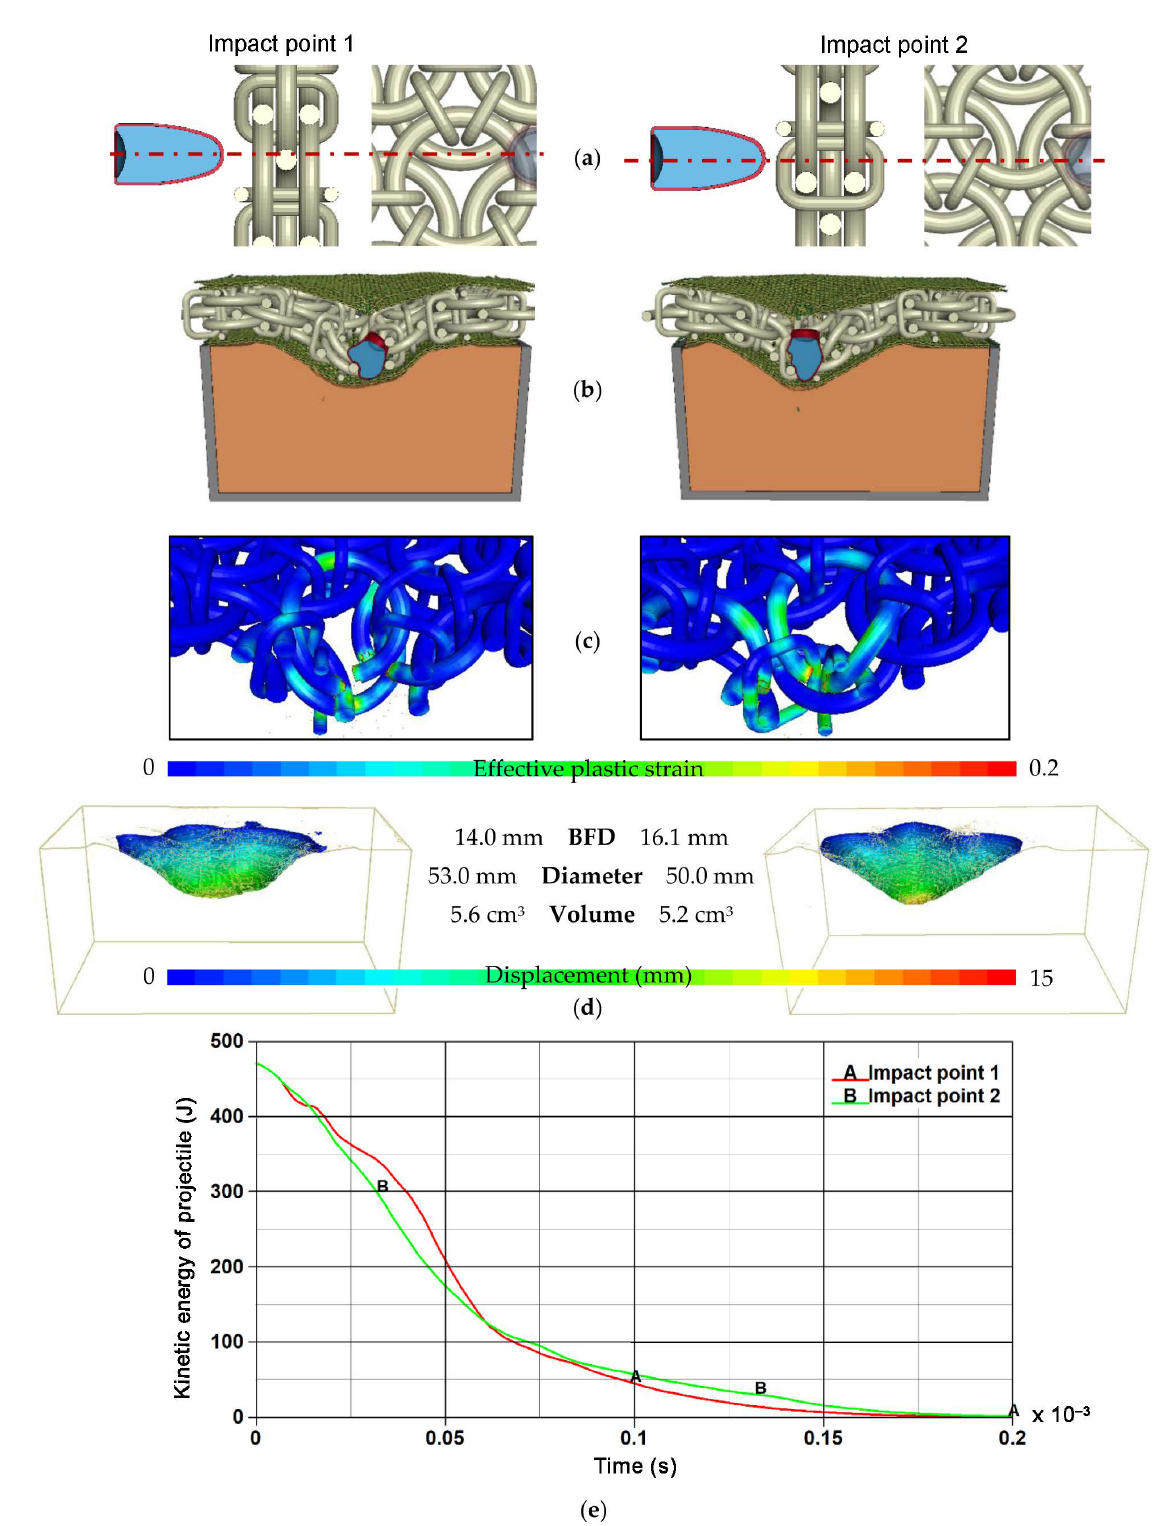
Figure 13. Results of simulation for S1 structure: ( a ) location of the impact point; ( b ) final deformation; ( c ) distribution of effective plastic strain in the titanium structure; ( d ) shape of the hollow in the ballistic clay and ( e ) plot of the projectile energy against time.